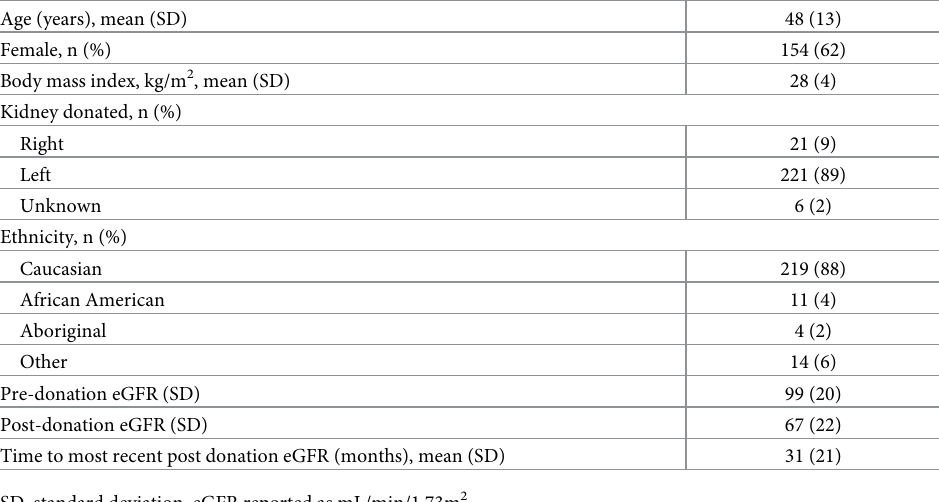
Table 1. Baseline characteristics of live kidney donor study population, n =